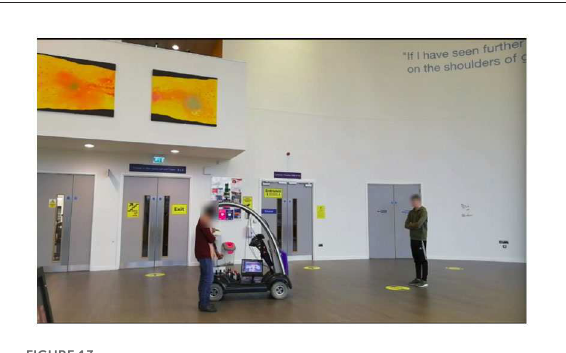
FIGURE13 OpenPodcar: Open source hardware AV (See preprint Camara et al., 2022).